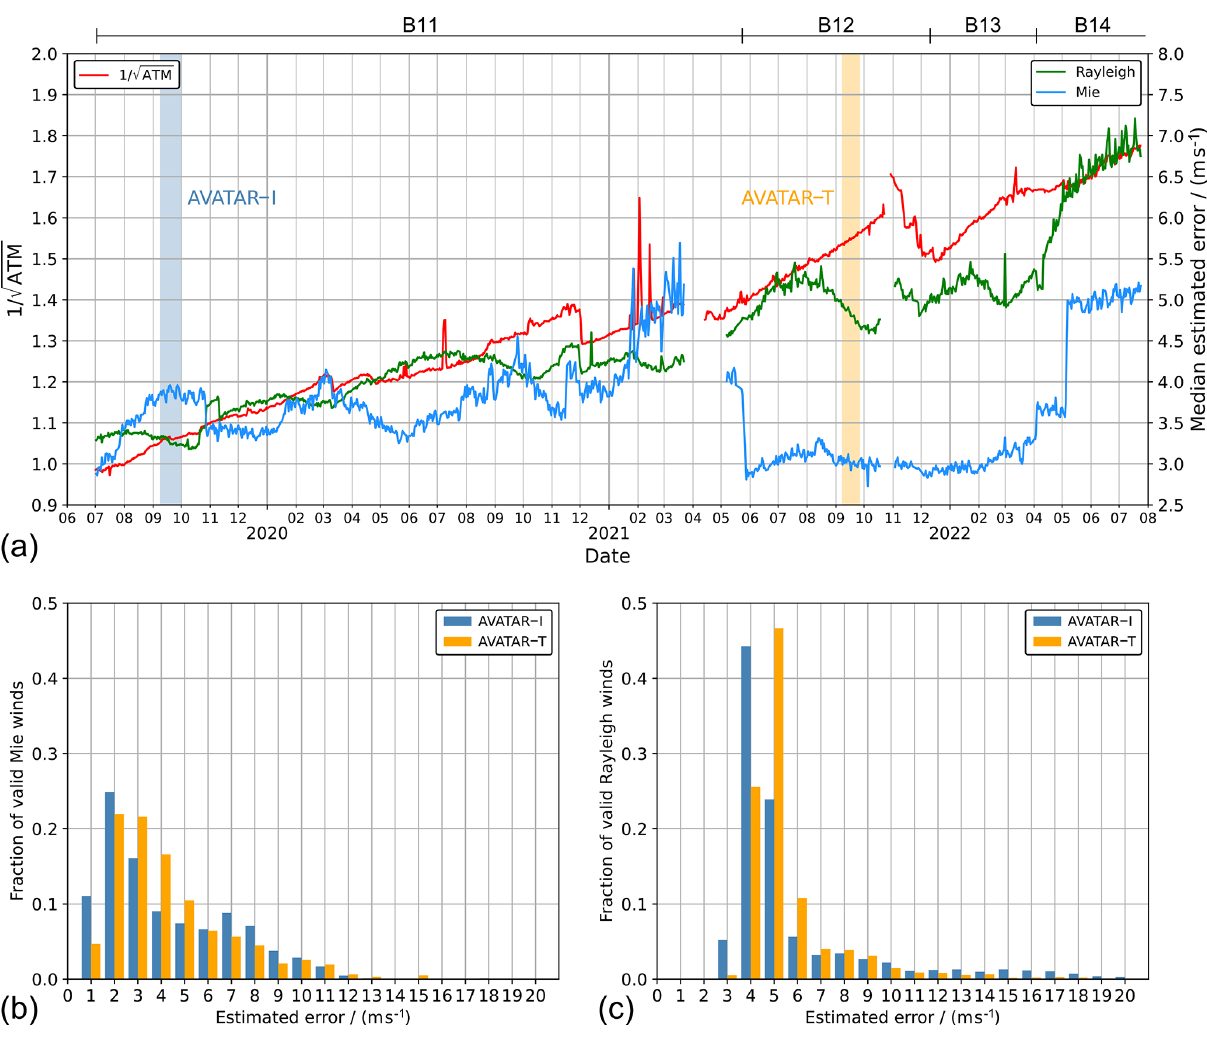
√ ATM) (red), normalized to the value